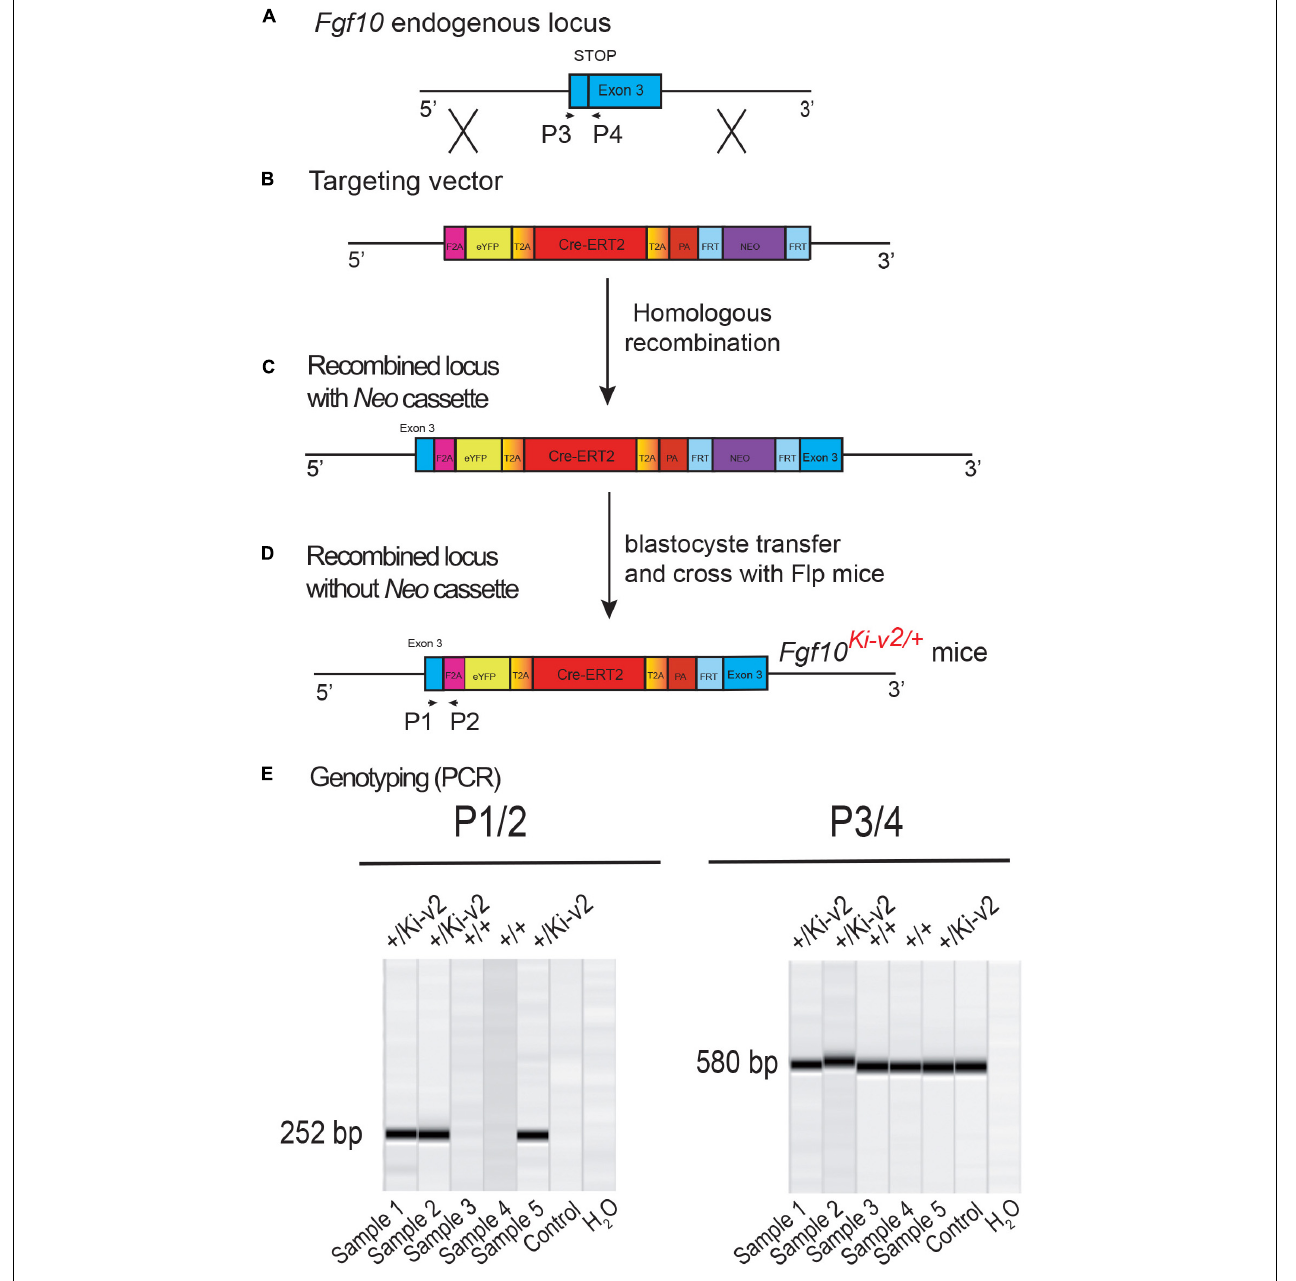
FIGURE 1 | Generation and genotyping of the novel Fgf10 Ki - v 2 line. (A,B) Homologous recombination was carried out to insert the F2A-eYFP-T2A-Cre-ERT2- T2A-PA-NEO construct in frame with the stop codon of exon 3 of the mouse Fgf10 gene. Neomycin resistance coding gene was used for the positive selection. (C,D) Recombined ES cell clones were treated with flipase to remove the Neo cassette and blastocyste transfer of the selected ES cells was carried out to generate chimera animals. (E) PCR strategy to genotype mutant and wild type animals. Primers 1 and 2 were used for the detection of the mutant Fgf10 Ki - v 2 allele (252 bp) and Primers 3 and 4 were used for the detection of the wild type Fgf10 + allele (580 bp).